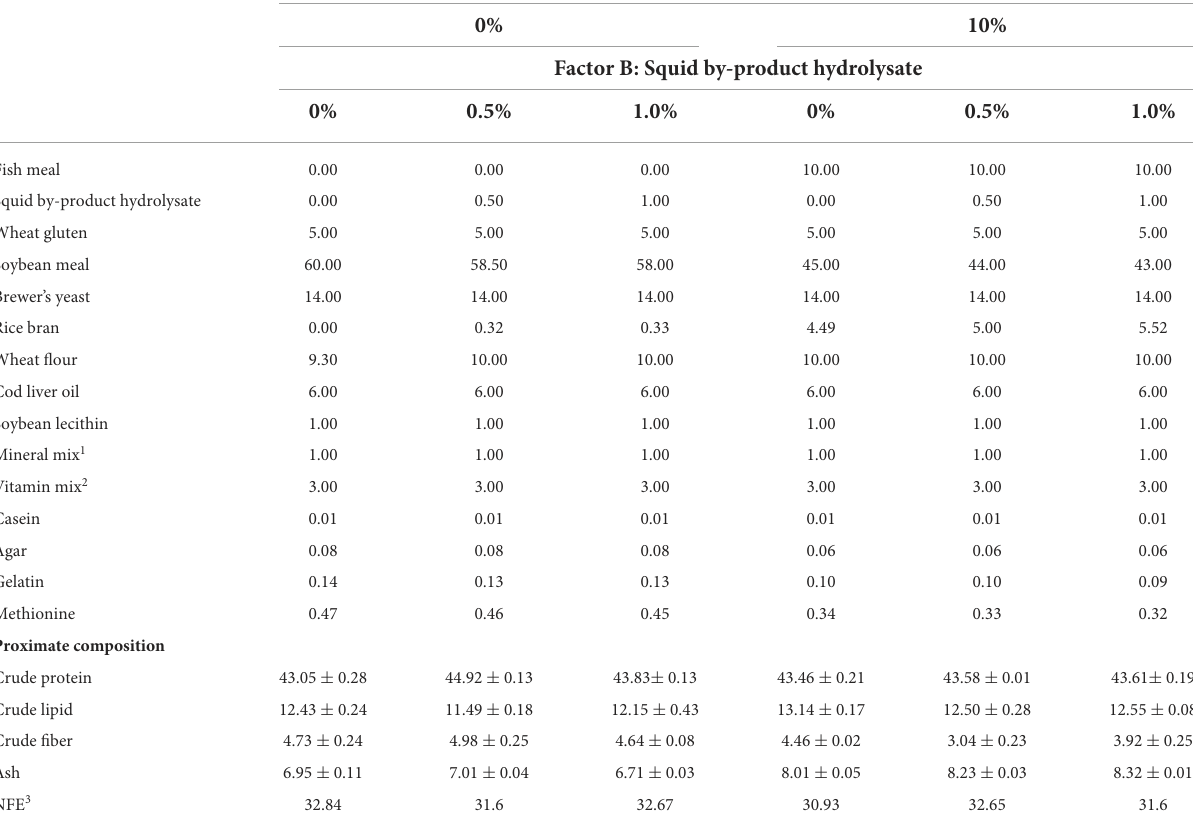
TABLE 1 Formulation and composition of the experimental diets (g 100 g − 1 diet, dry